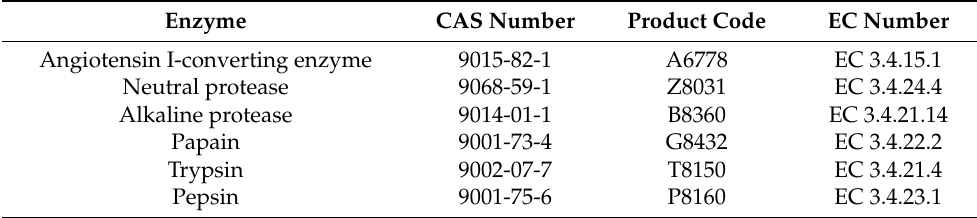
Table A1. Product information and EC numbers of all the enzymes used in this